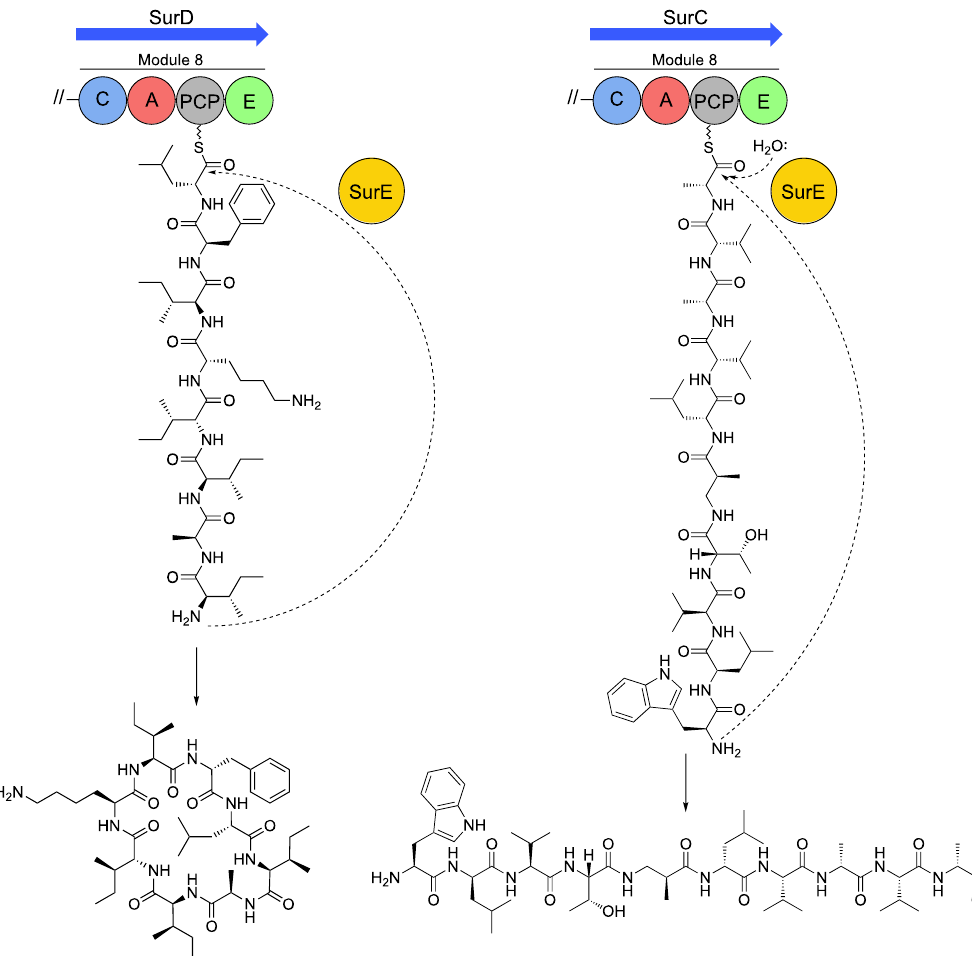
Figure 4. SurE-mediated offloading/cyclisation of surugamide A ( left ) and surugamide F ( right ) from the terminal biosynthetic modules of SurD and SurC, respectively.